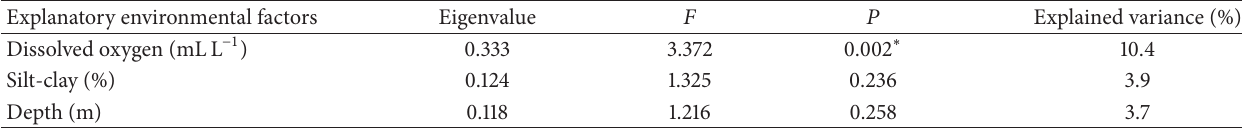
Table 4: Results of stepwise selection which relates significant environmental factors with mollusk genera. ∗ 𝑃 > 0.05 . Eigenvalues = 3.197. Explanatory environmental